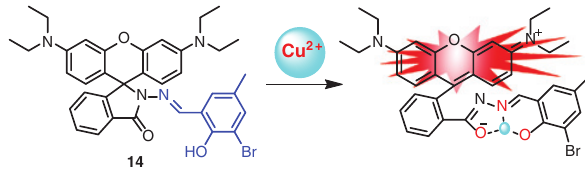
Figure 11: Recognition mechanism of probe 14 with Cu 2 + .